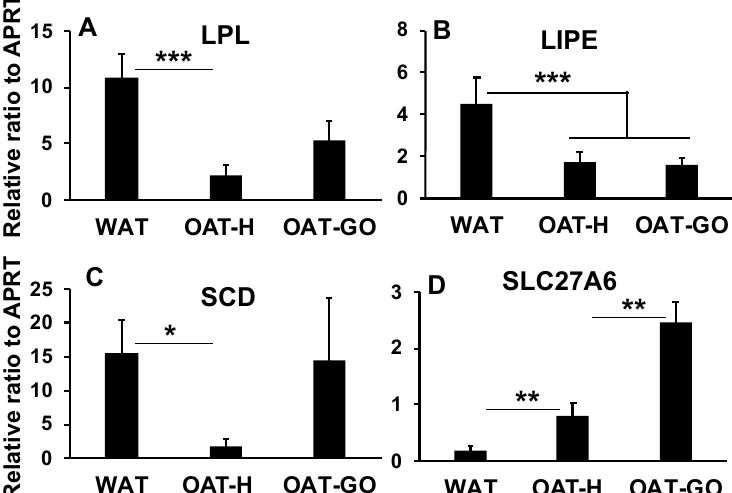
Figure 5. QPCR analysis of lipid metabolisms of OAT compared with WAT. Total RNA was isolated from OAT-H ( n = 4), OAT-GO ( n = 9) and WAT ( n = 6) ex vivo fat tissues. LPL ( A ), LIPE ( B ), SCD ( C ) and SLC27A6 ( D ) were analyzed using relative ratio of gene expression by QPCR, and housekeeper gene APRT served as the reference gene. Histograms = mean ± SEM of all samples studied. * p < 0.05; ** p ≤ 0.02; *** p ≤